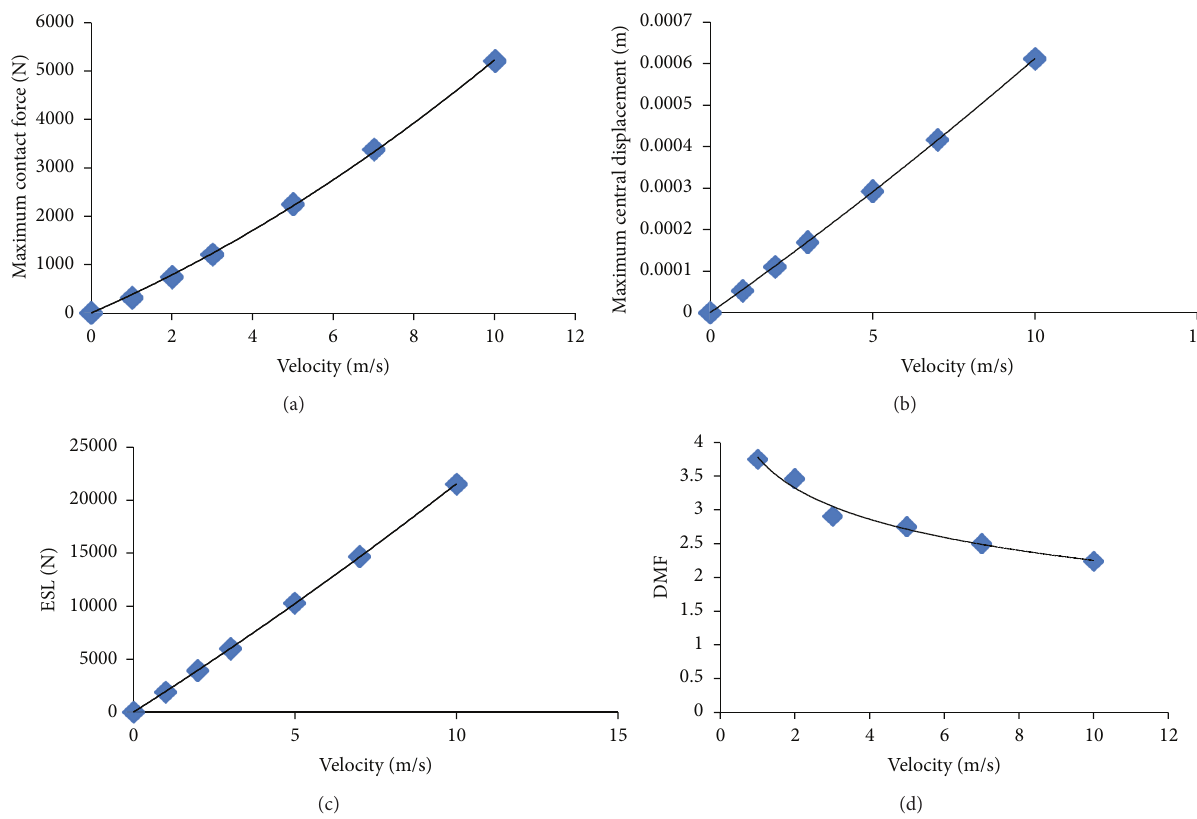
Figure 10: Variation of maximum impact load, maximum displacement, equivalent static load, and dynamic magnification factor with velocity for simply supported angle ply (CL/CP) composite hypar